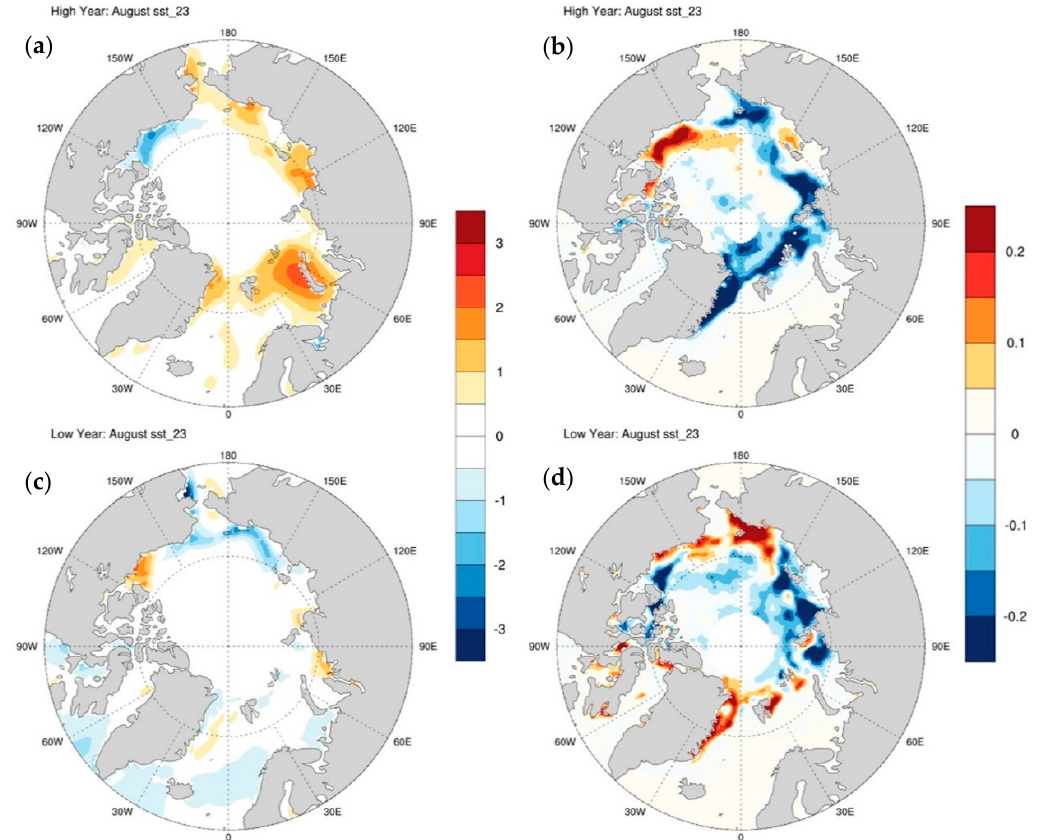
Figure 4. Composite anomalies of ( a , c ) August SST (shade interval: 0.5 K) and ( b , d ) September SIC (shade interval: 0.05). The top (bottom) two plots correspond to the years when August sst_23 (81.9° N, 18.2° W) is one standard deviation larger than its climatology mean in the positive (negative) phase.